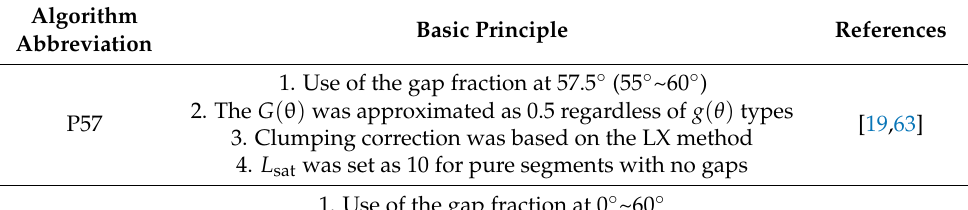
Table 2. PAI true algorithms in the